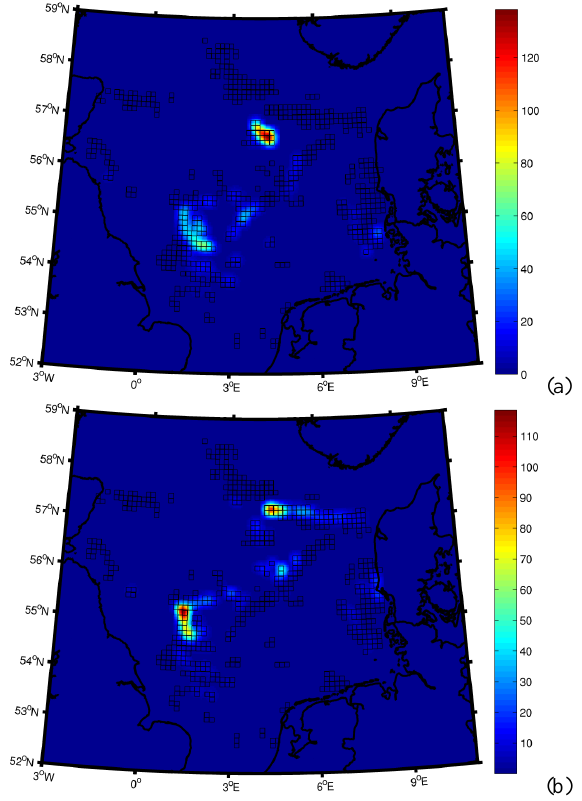
Fig. 8. Recruitment (million larvae per km 2 by end June) for 1997. (a) Recruitment intensity plotted by source and (b) recruitment in- tensity plotted by destination. Small transparent boxes show suit- able habitat areas (as 10 × 10km boxes) for sandeel.